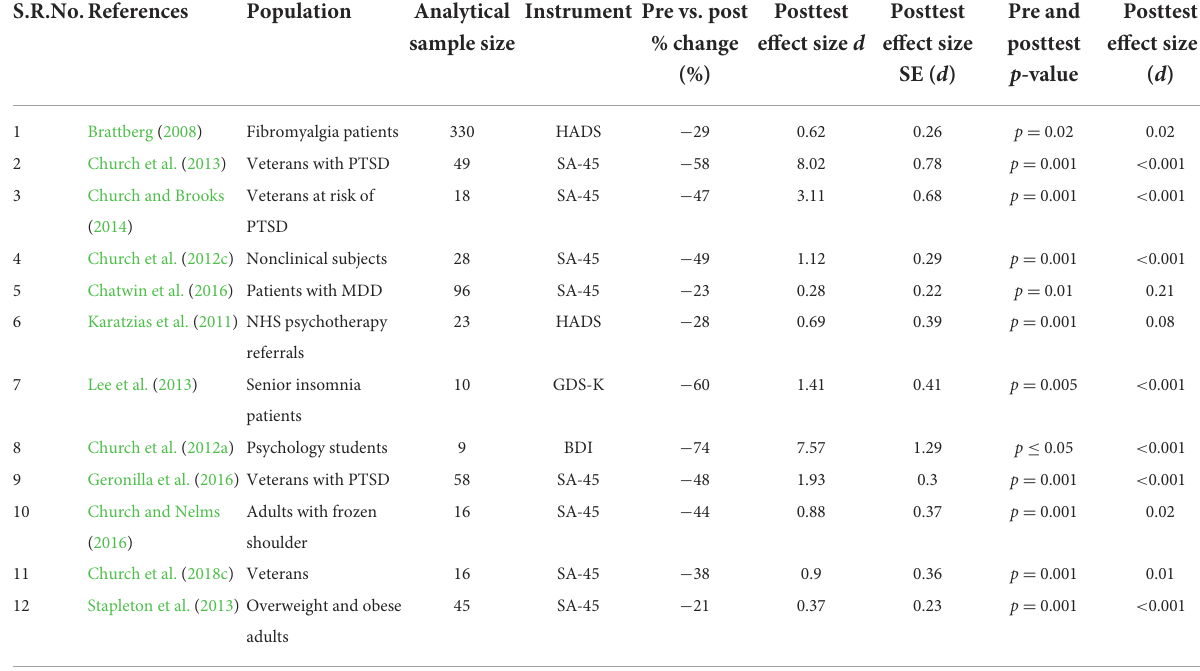
TABLE 4 Depression RCTs included in Nelms and Castel (2016)